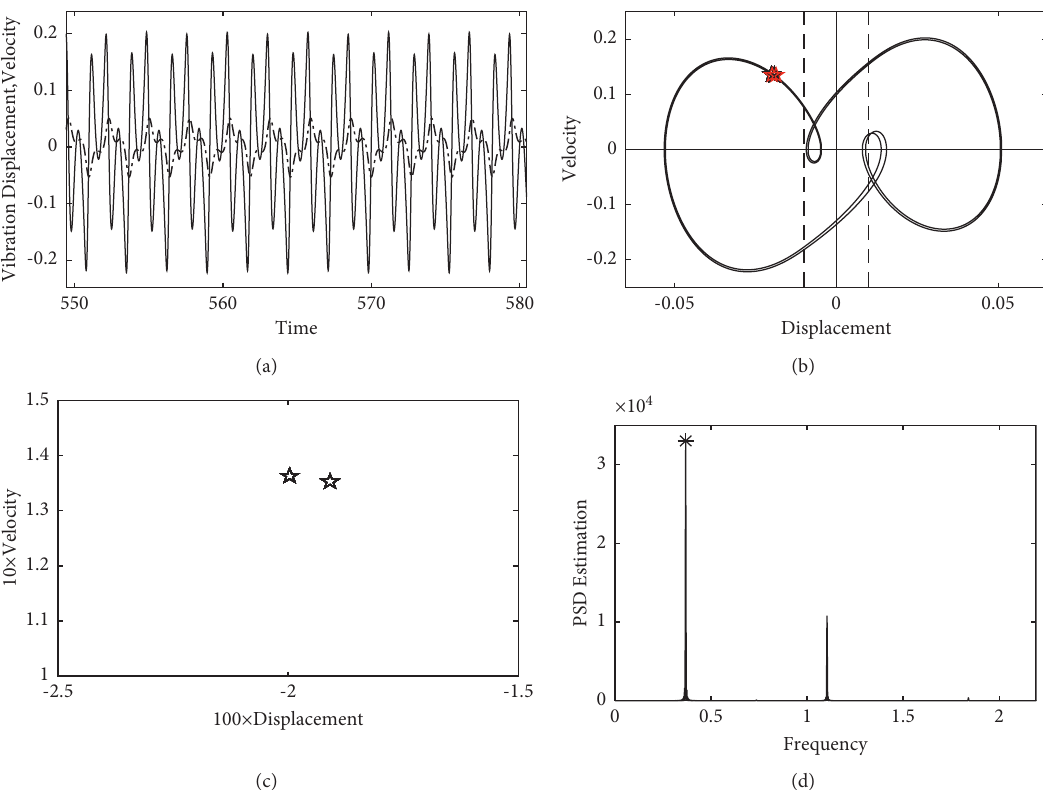
Figure 13: f � 0 . 368Hz, Asymmetric period 2-2-4. (a) Time history graph. (b) Phase diagram. (c) Poincar´e section. (d) Power spectral density diagram.